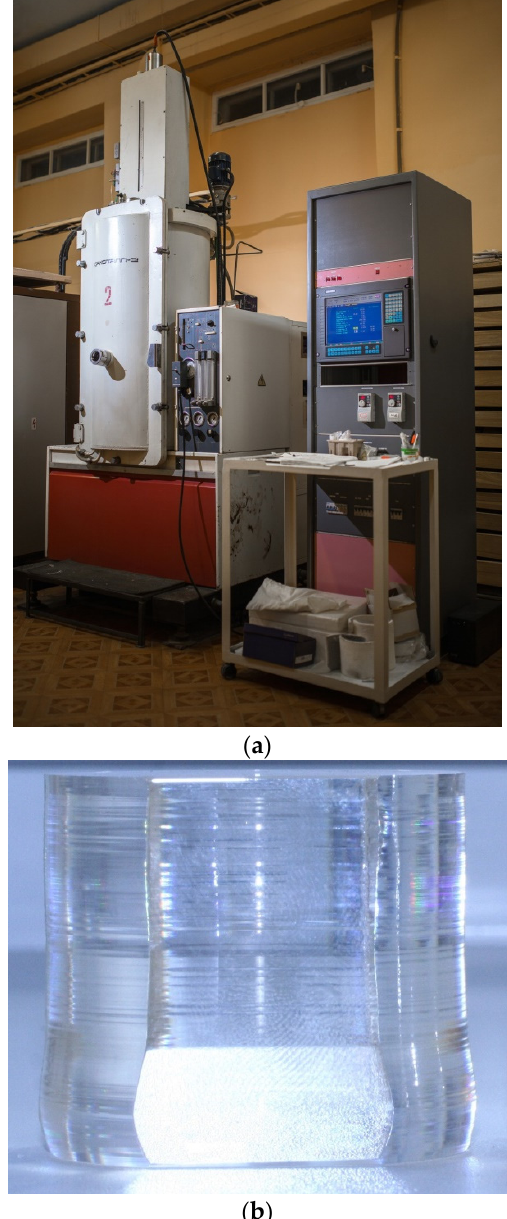
Figure 1. Kristall 2 growth setup for growing lithium niobate crystals using the Czochralski method—( a ); crystal LiNbO 3 :Gd 3+ (0.003):Mg 2+ (0.65 wt.%) ( b ). Figure is reproduced with the permission of Elsevier from the paper [34].